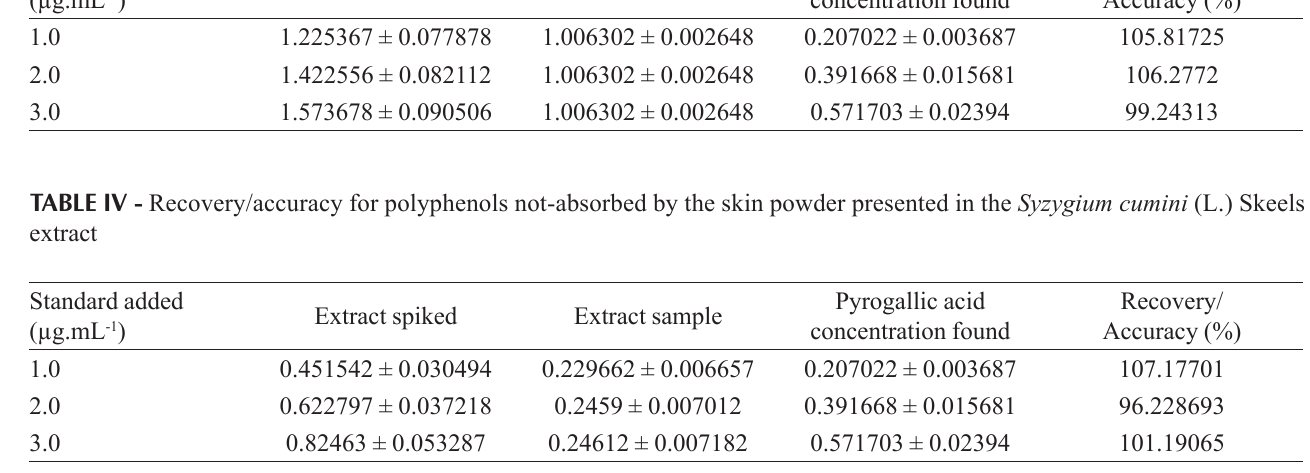
TaBLe III - Recovery/accuracy for the total polyphenols, as pyrogallic acid equivalents, presented in the Syzygium cumini (L.) Skeels extract Standard